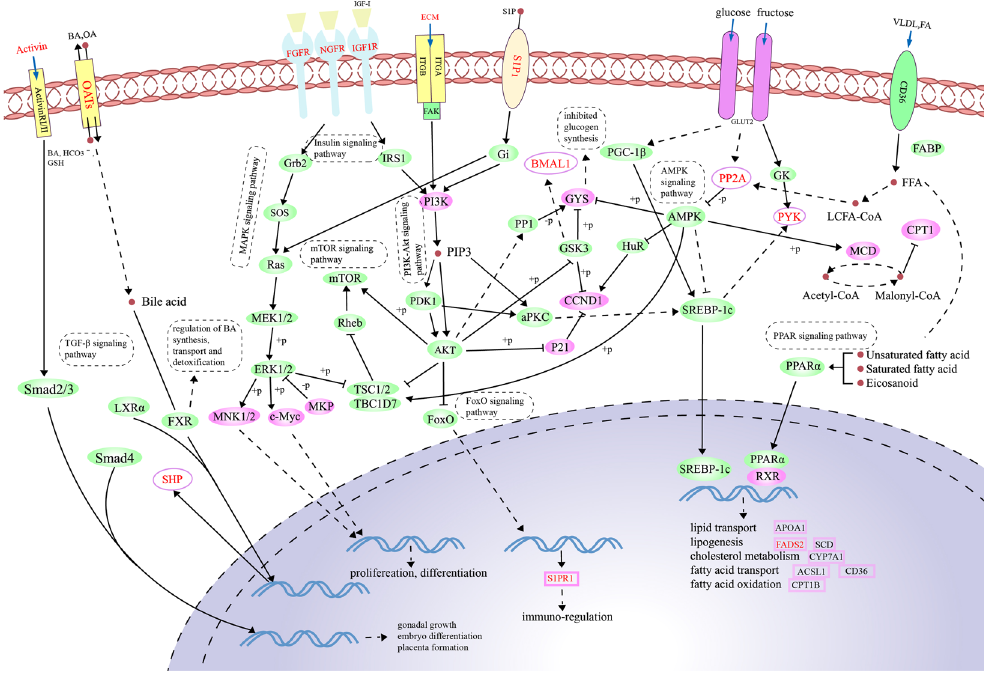
Figure 3. Metabolic networks involving in insulin, PI3K-Akt, AMPK, MAPK, mTOR, FoxO, and PPAR signaling pathways. Green ovals represent proteins involved in pathways; pink ovals (rectangles) represent the differentially expressed proteins (genes) identified in this study; the 12 genes in ceRNA networks are marked in red font, of these, BMAL1, ECM, IGF1R, NGFR, Activin, FGFR, PYK, SHP, S1P 1 , OATs, and PP2A protein in the networks respectively encoded by ARNTL , COL6A1 , IGF1R , NGFR , INHBE , FGFR4 , PKLR , NR0B2 , S1PR1 , SLC22A7 and PPP2R2B genes, and the remaining FADS2 gene is in the pink